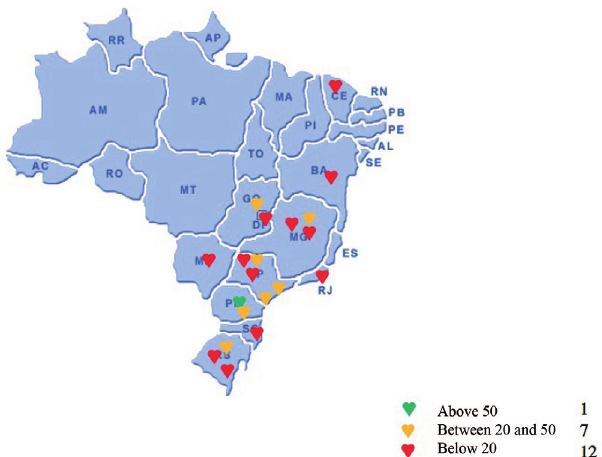
Figure 3 - Distribution of the top 20 hospitals operating patients between 0-29